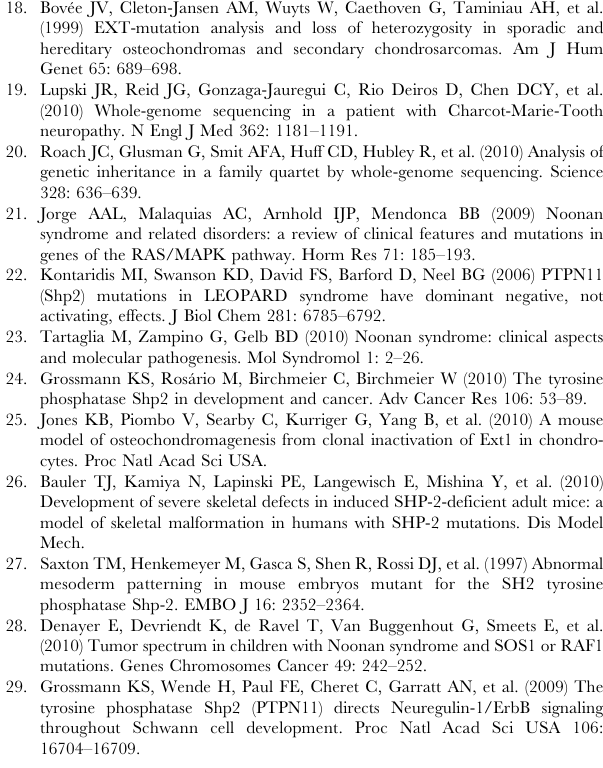
Table S6 Primers used for amplification of PTPN11 coding exons. (DOC) Table S7 Probes used for MLPA. (DOC) Text S1 Supporting Materials and Methods.